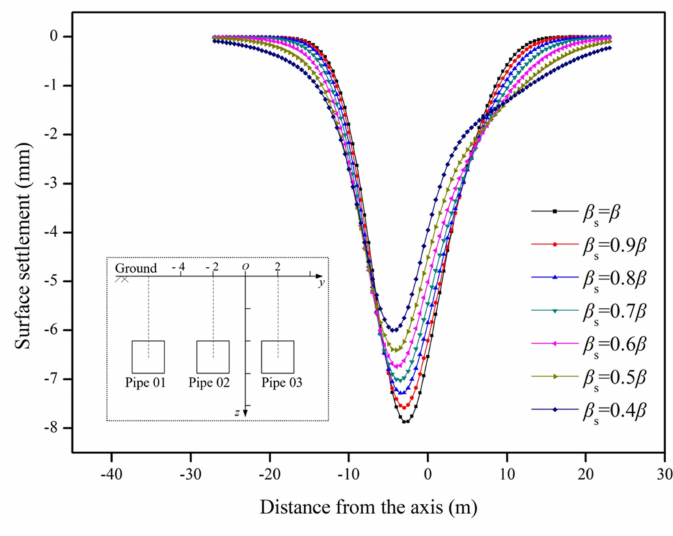
Figure 15. Curves of transverse surface settlement.